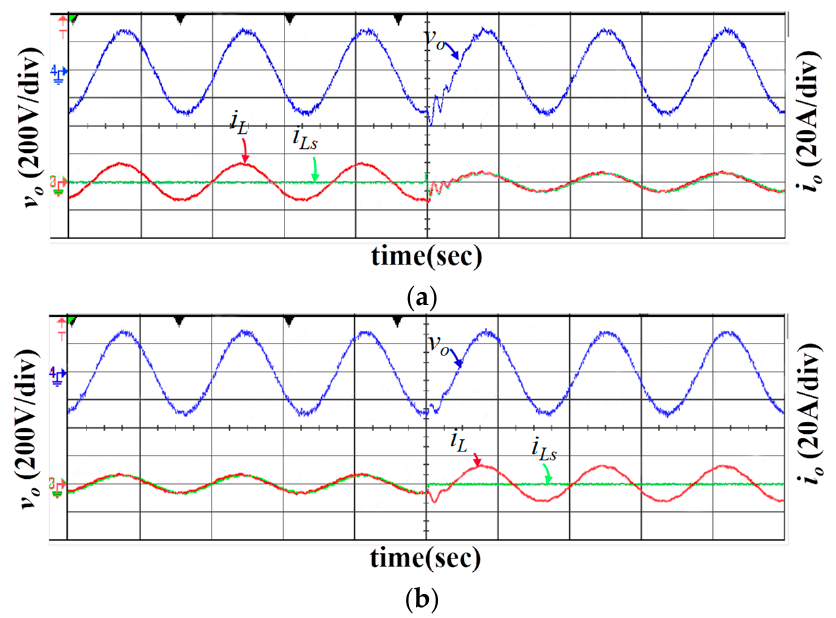
Figure 13. Experimental results under slave inverter connection and disconnection by SMC: ( a ) slave inverter connection; ( b ) slave inverter.